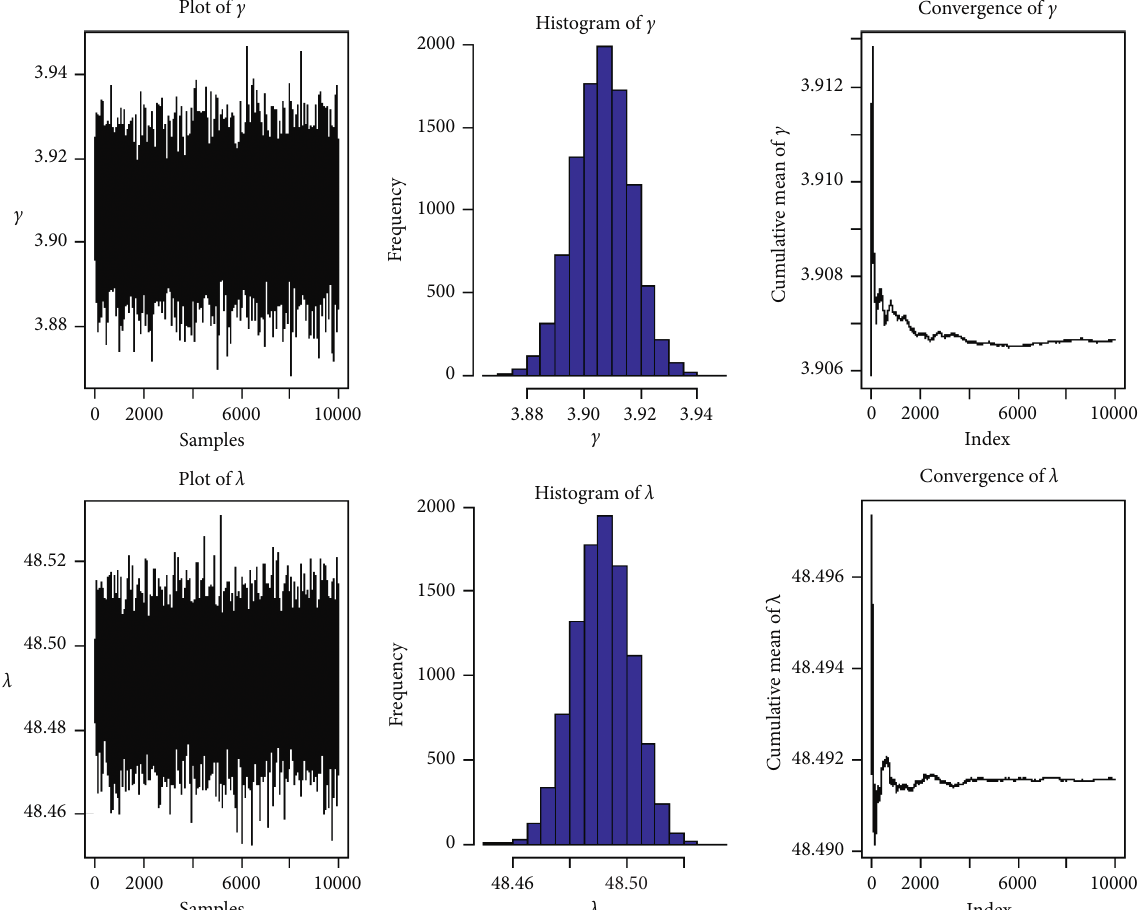
Figure 3: Convergence of MCMC estimates for c and λ implementing the MH method for the data set II under PCTI m � 5 and f �